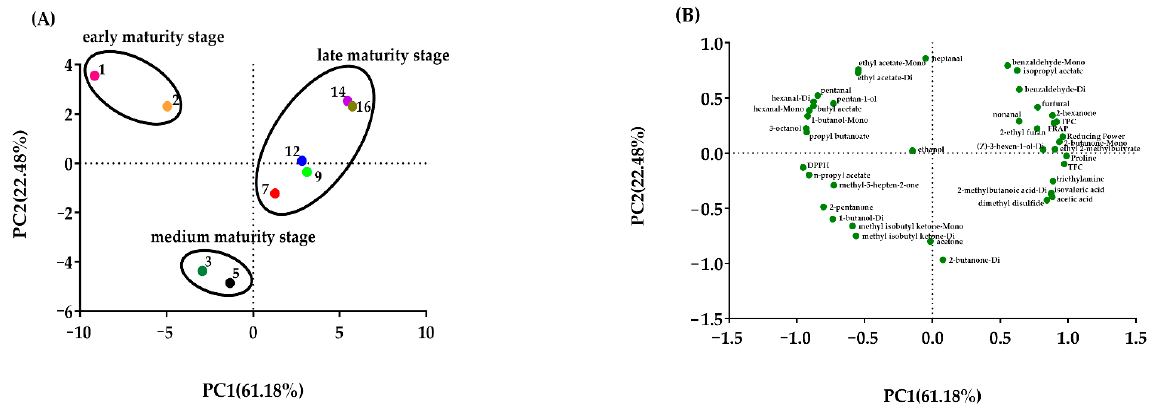
Figure 3. The principal component analysis (PCA) score plots ( A ) and PCA loading plots ( B ) of antioxidant and volatile components in different maturity rape honey samples. TPC: total phenolic content. TFC: total flavonoids content. FRAP: ferric reducing/antioxidant power.